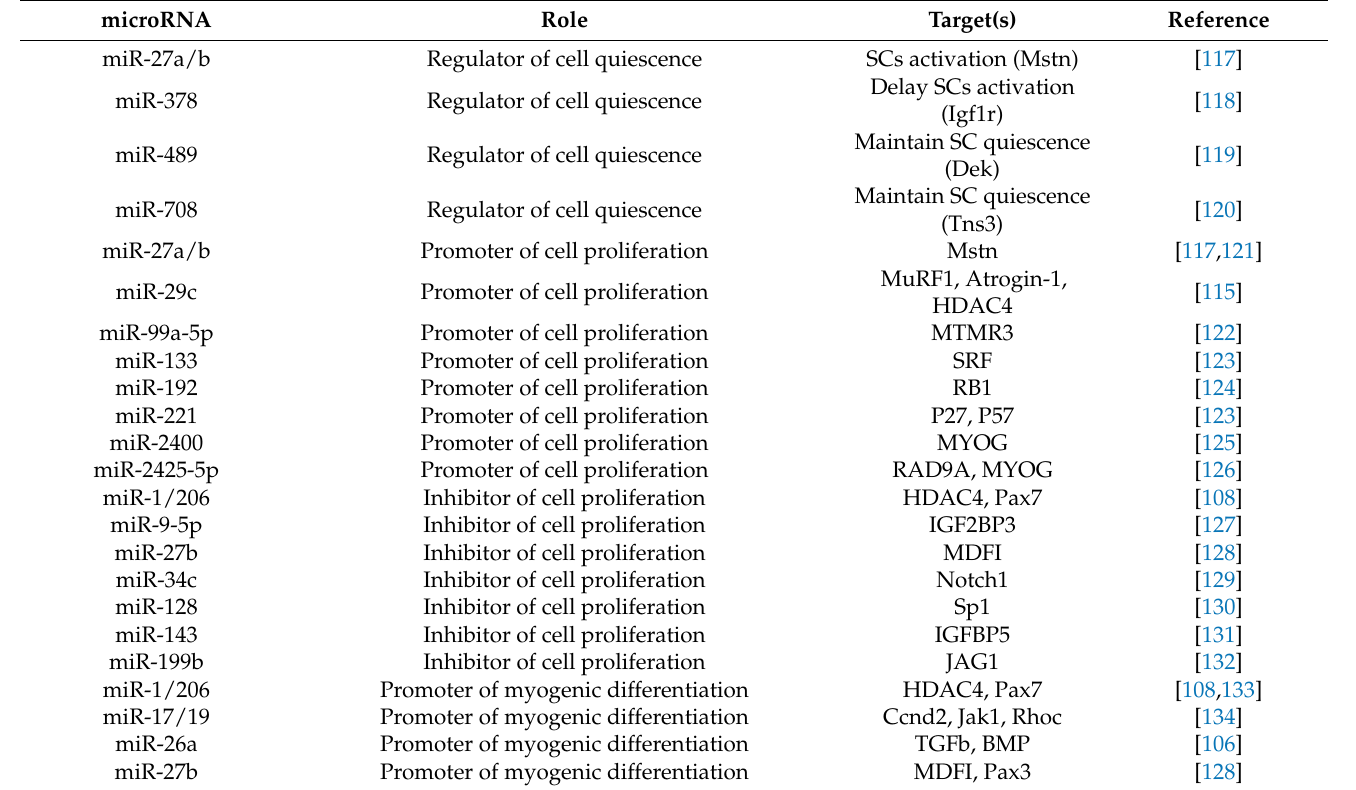
Table 4. MicroRNAs in myogenesis